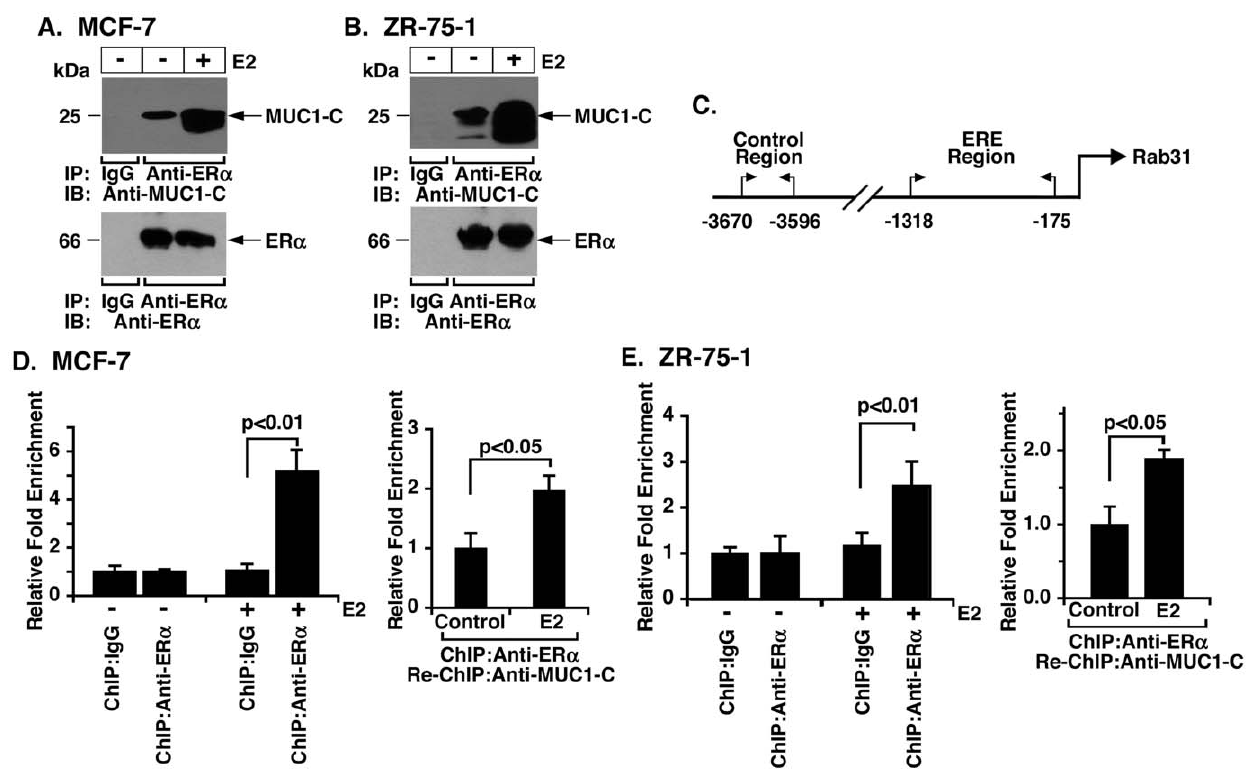
Figure 4. MUC1-C associates with ER a on the Rab31 promoter. A and B. Lysates from MCF-7 (A) and ZR-75-1 (B) cells left untreated or stimulated with E2 for 24 h were immunoprecipitated with anti-ER a or a control IgG. The precipitates were immunoblotted with anti-MUC1-C or anti- ER a . C. Schema of the Rab31 promoter highlighting the positions of the control region (CR) and the proximal region encompassing estrogen response elements (EREs). D and E. Soluble chromatin from MCF-7 (D) and ZR-75-1 (E) cells left untreated or stimulated with E2 for 24 h was precipitated with a control IgG or anti-ER a . The precipitates were analyzed for Rab31 promoter ERE or CR sequences (left). The results (mean 6 SD of three determinations) are expressed as the relative fold enrichment compared to that obtained with the IgG control. In re-ChIP experiments, the anti- ER a precipitates were released, reimmunoprecipitated with anti-MUC1-C, and then analyzed for Rab31 promoter sequences (right). The results (mean 6 SD of three determinations) are expressed as the relative fold enrichment compared to that obtained with the unstimulated